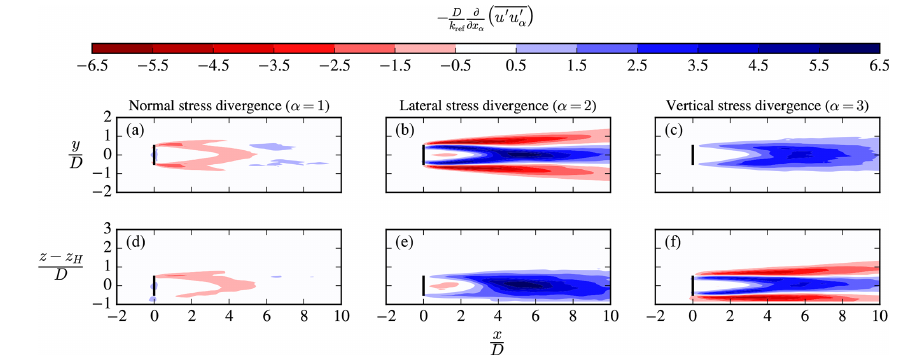
Figure 2. Wake recovery in terms of stress divergence from an LES single wake simulation. (a–c) Lateral wake recovery at hub height. (d–f) Vertical wake recovery at y =